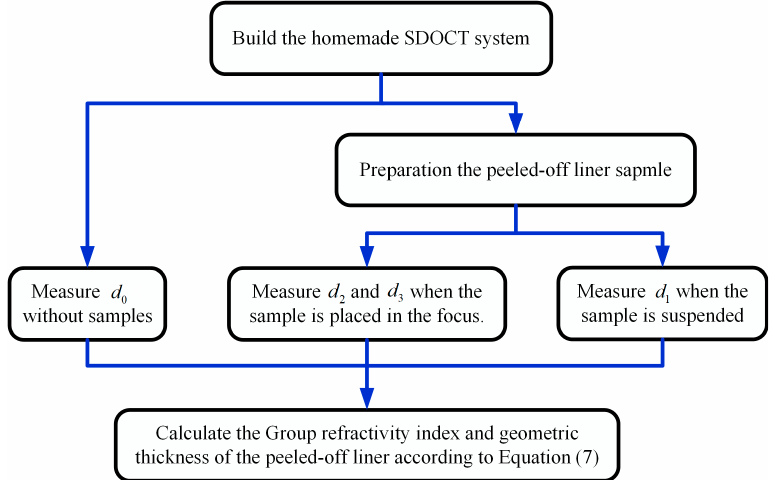
Figure 2. The stepwise flowchart for the measurement of the group refractivity index and the geometric thickness of the peeled-off self-lubricating fabric liner.